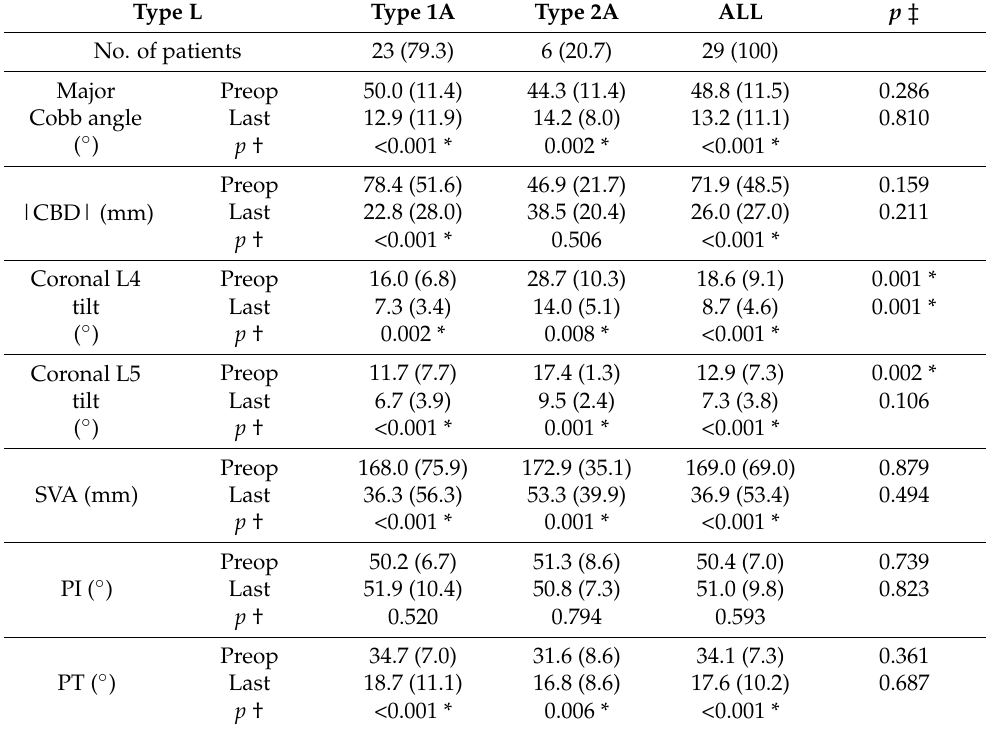
Table 3. Preoperative and postoperative spinopelvic parameters of the two groups. Data presented as mean (SD) or number of patients (%). CBD, coronal balance distance, SVA, sagittal vertical axis; PI, pelvic incidence; PT, pelvic tilt; SS, sacral slope; LL, lumbar lordosis; TK, thoracic kyphosis; PJA, proximal junctional angle. † Comparison with pre op, ‡ comparison between groups. * p < 0.05 statistically